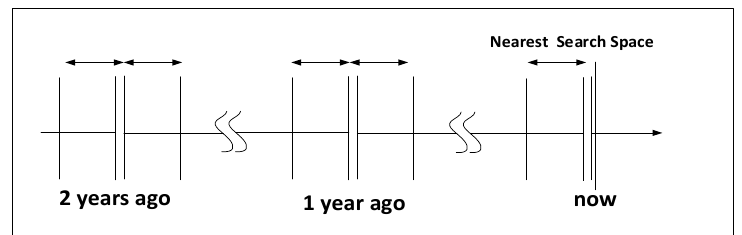
Figure 2. Limitation of search space for similar